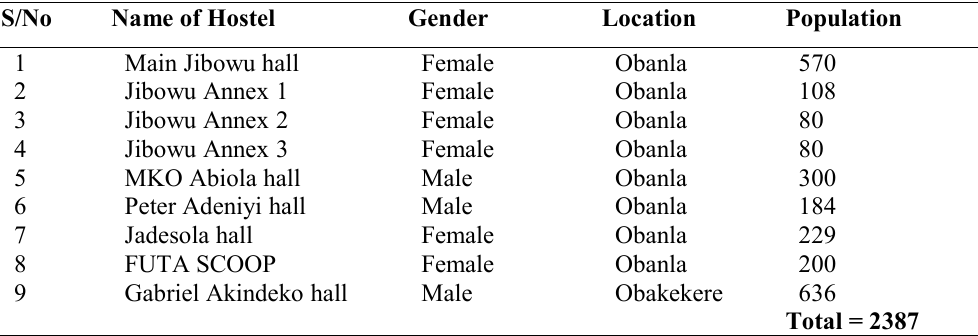
Table 1. The List of Undergraduate Hostels in FUTA with their Location and